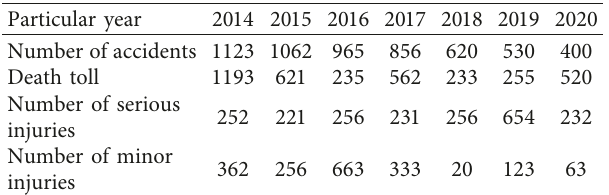
Table 1: Statistics of safety production casualty accidents of construction projects in